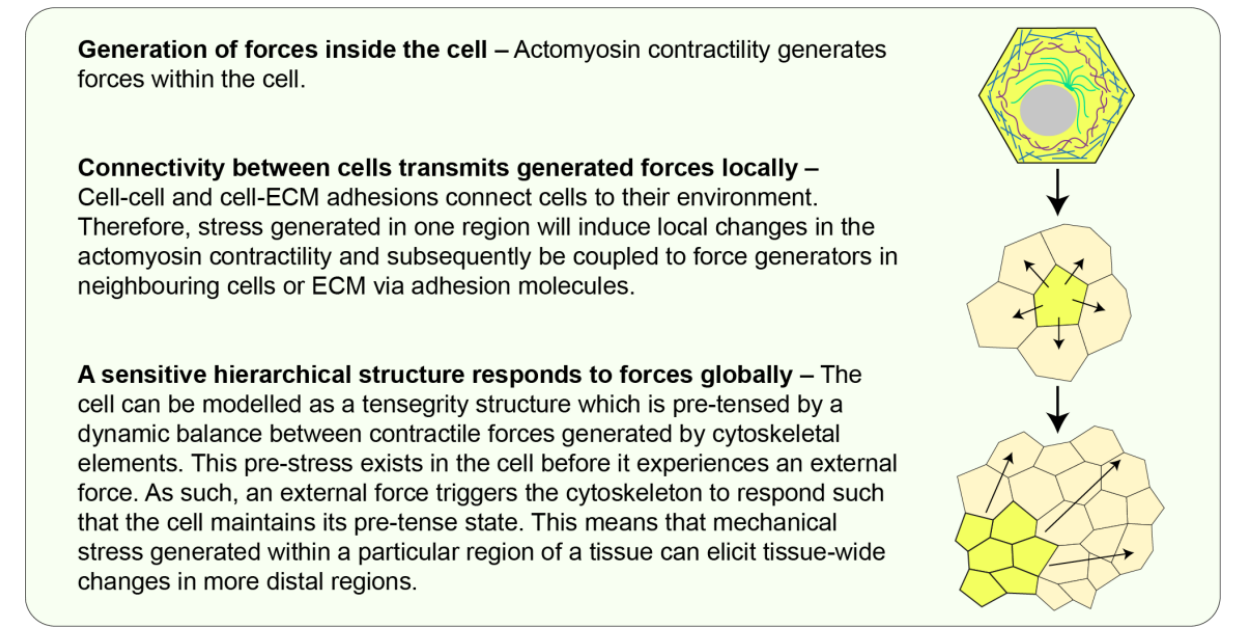
Figure 2. Building forces from cells to tissues. Forces generated within a cell can be transmitted to its interconnected neighbours. Cells can be modelled as tensegrity structures and tissues are, therefore, a collection of tensegrity structures which are inherently mechanosensitive [14 – 16].